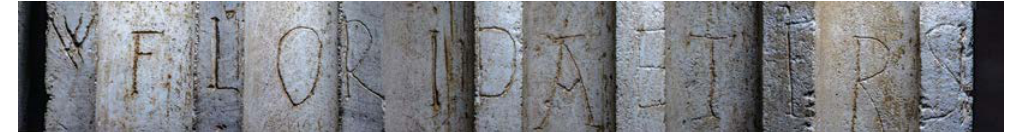
Figure 7 – Graffito ‘W Florida e Tirsi’. Photo by Manuele